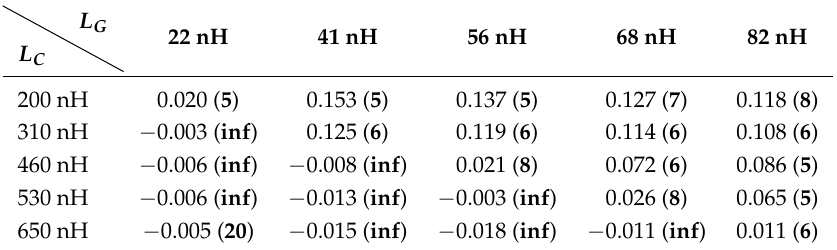
Table 5. A comparison between the ζ 2 and number of oscillation cycles N C ( bold ) with various L C and L G with R G = 1.5 Ω .